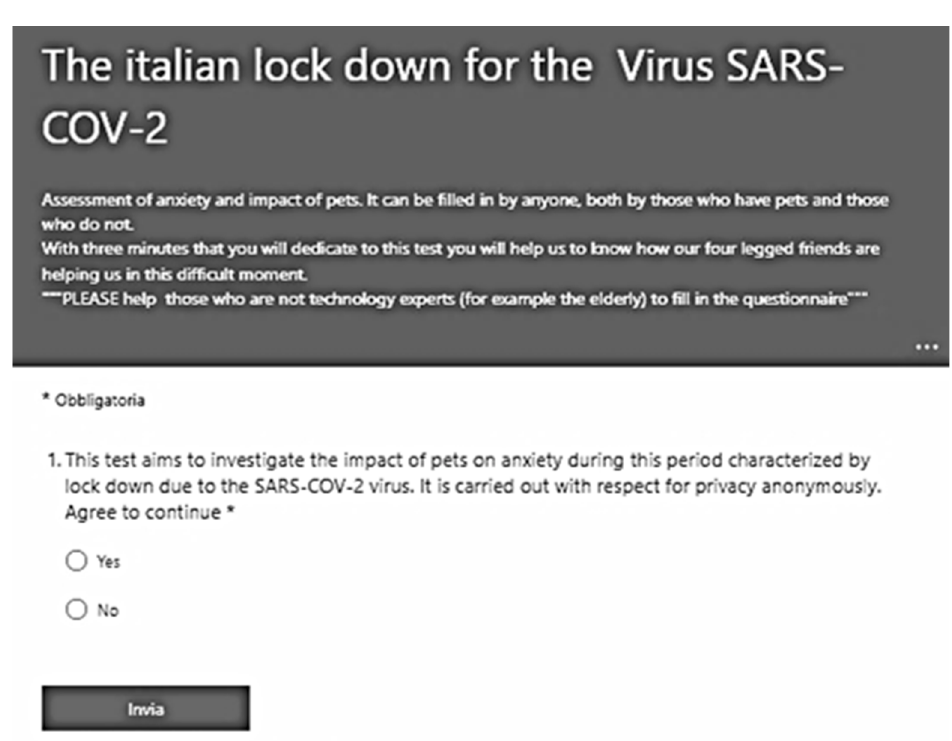
Figure A3. Introduction of the eS with the invite to help those who are not technology experts. “*” indicates mandatory questions.